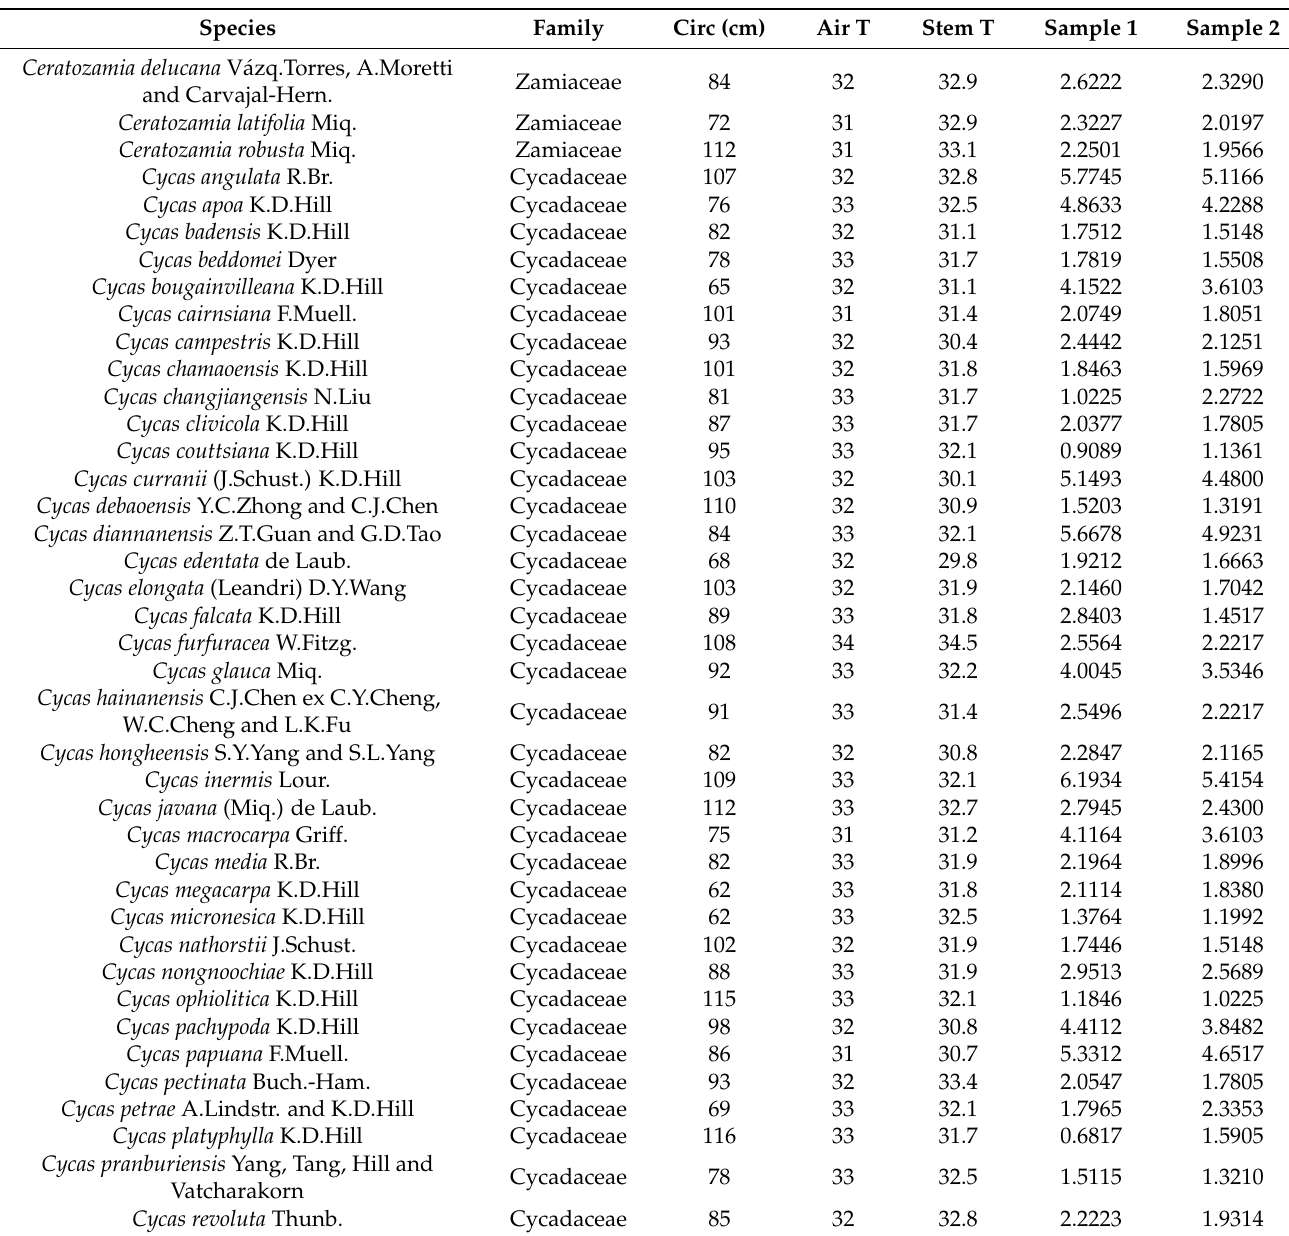
Table A1. List of cycad species included in the carbon dioxide efflux study. Circ = circumference, Air T = air temperature, and Stem T = surface temperature of